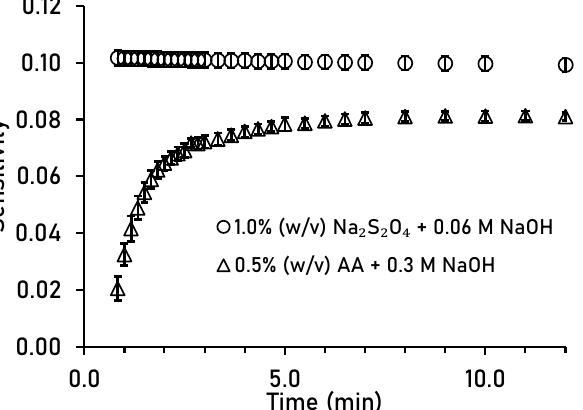
Figure 3. Effect of reducing agent on sensitivity of paraquat analysis. Experimental conditions: 10.00 mL of standard paraquat, 0.50 mL of reducing agent, 1000 rpm of stirring speed, and 30 s of stirring time.